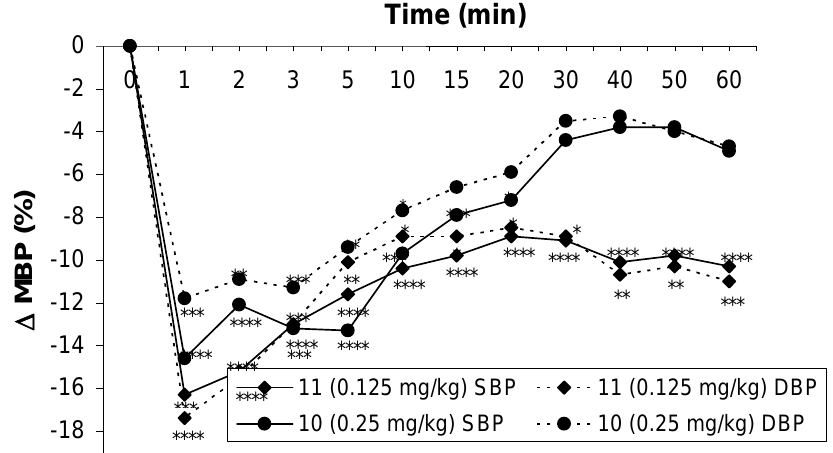
Figure 3. Changes in mean blood pressure after iv administration of the tested compounds in the lowest effective